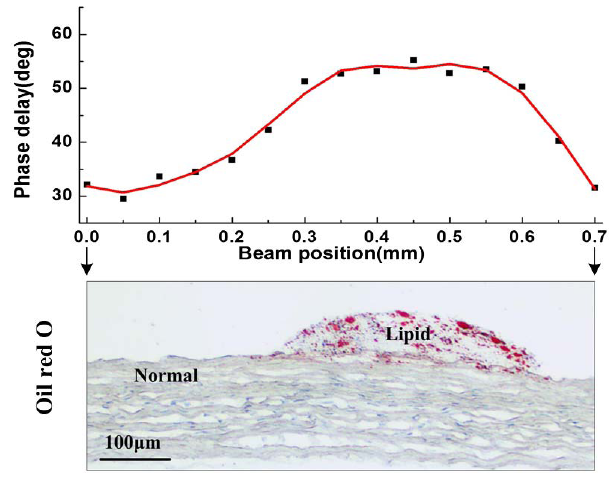
Fig. 7. Variation in phase delay as the laser beam scans across the vessel wall from the normal region to the lipid lesion.